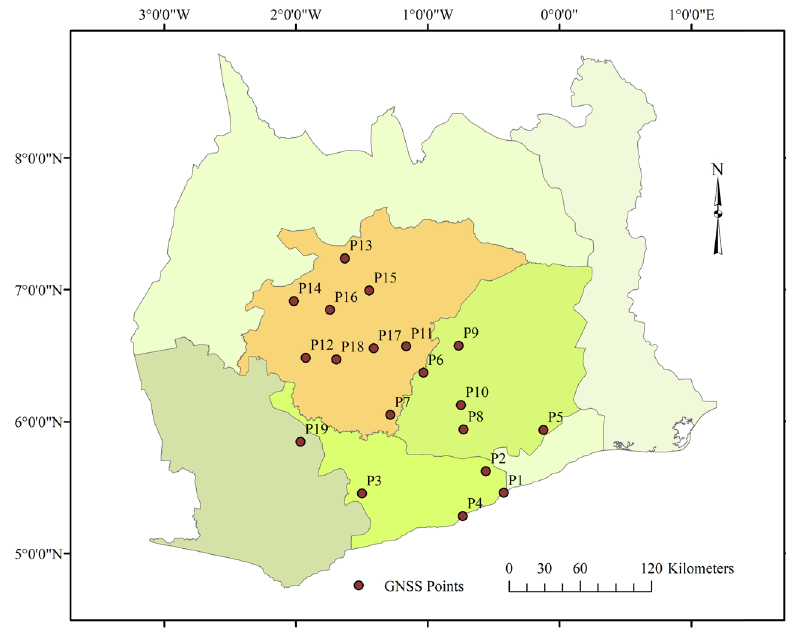
Figure 2: Spatial distribution of GNSS control points in the study